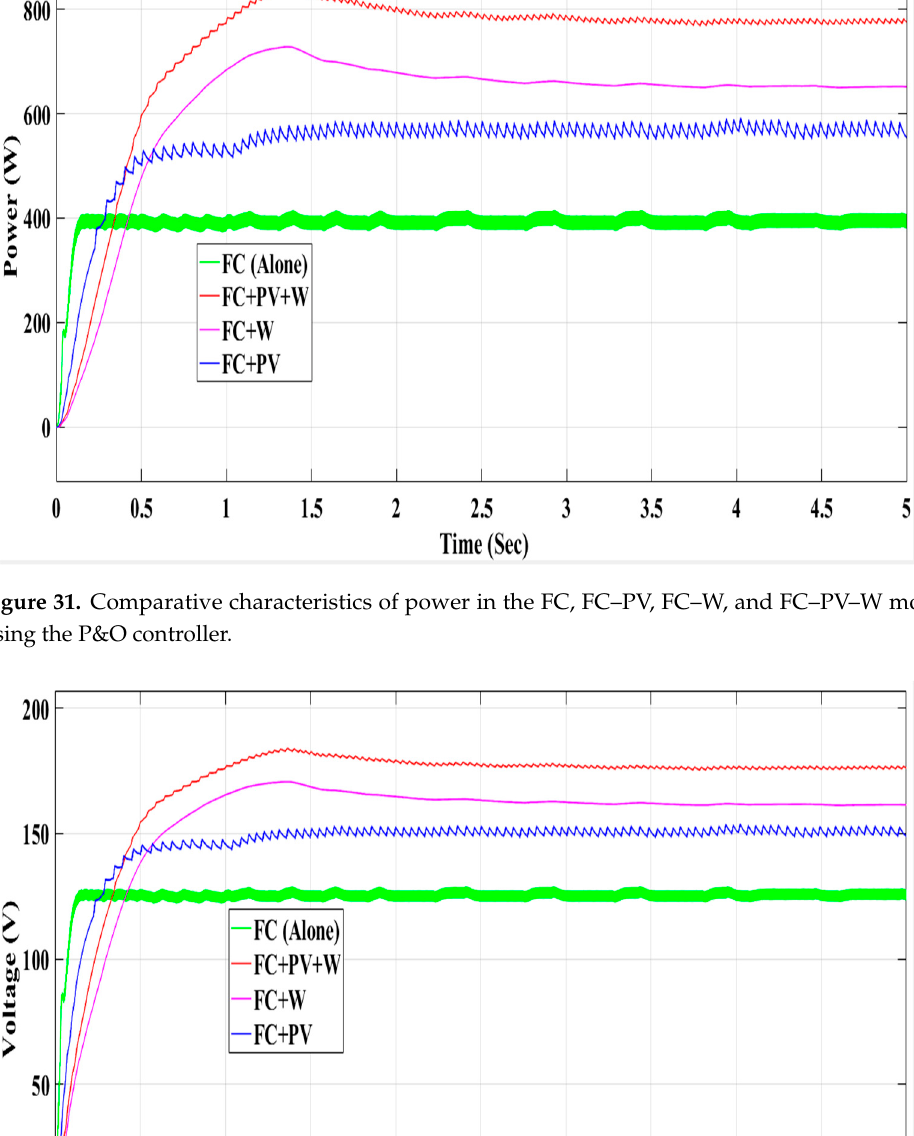
Figure 30. Power and voltage characteristics of the FC–PV–W model using a fuzzy logic controller.